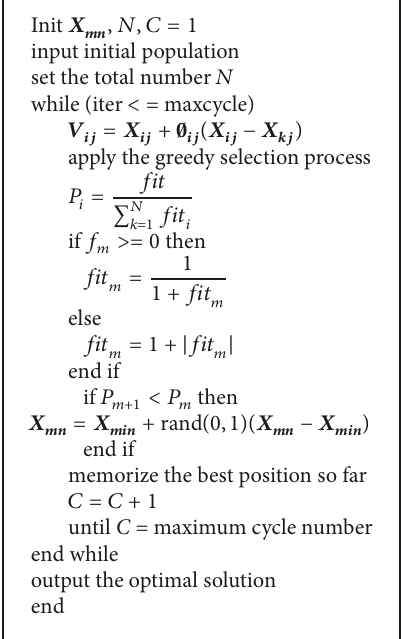
Algorithm 1: The program diagram of the artificial swarm opti- mization